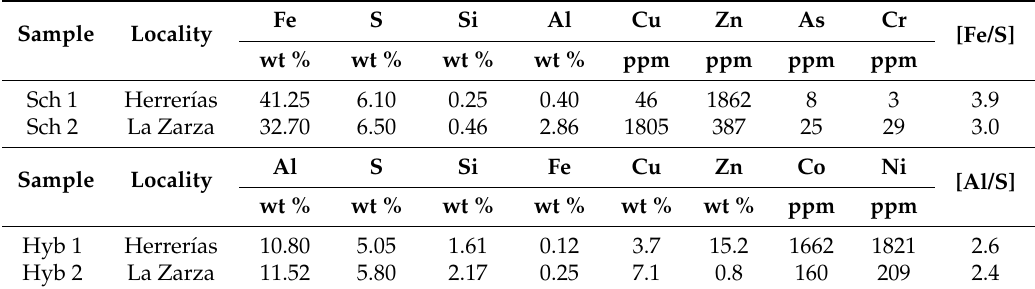
Chemical composition (ICP-MS, ICP-AES) of schwertmannites (Sch 1, Sch 2) and hydrobasaluminites (Hyb 1, Hyb 2) obtained by neutralization of acidic mine water from Herrer í as